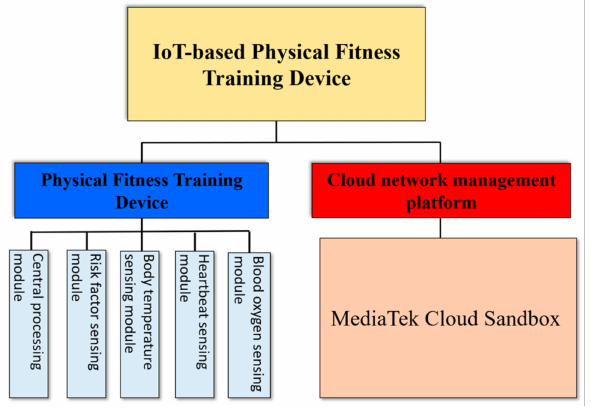
Figure 3. Architecture of the proposed